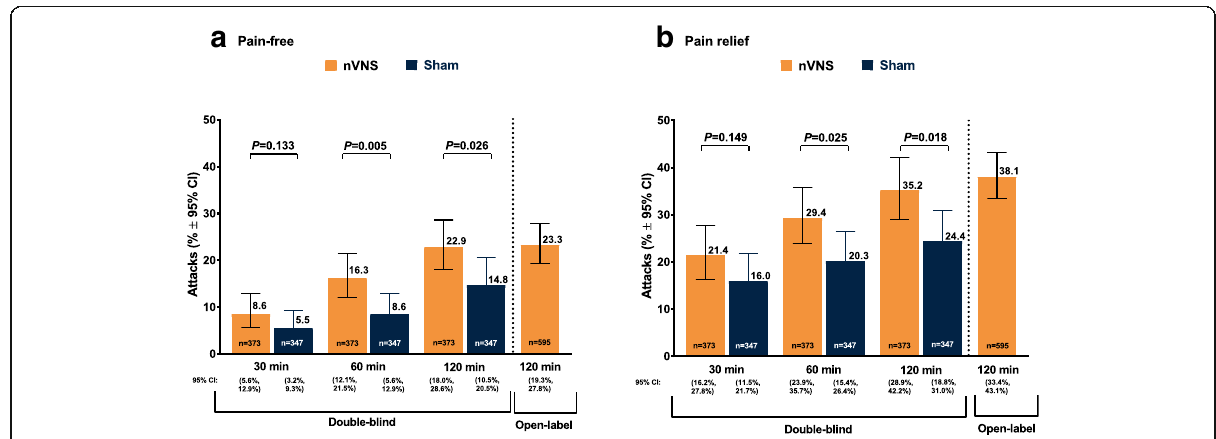
Fig. 2 Percentage of all treated attacks that were pain-free ( a ) or had pain relief ( b ) during the double-blind and open-label periods (ITT population, N =243). Generalized linear mixed effects regression models were used to estimate the proportion of successful responses, allowing for both subject- specific and population-averaged inferences in non-normally distributed data. P values are from resulting F tests. Models were adjusted for subject ’ s pain score at baseline, use of preventive therapies, and indicator or presence of aura. Abbreviations: CI, confidence interval; ITT, intent-to-treat;